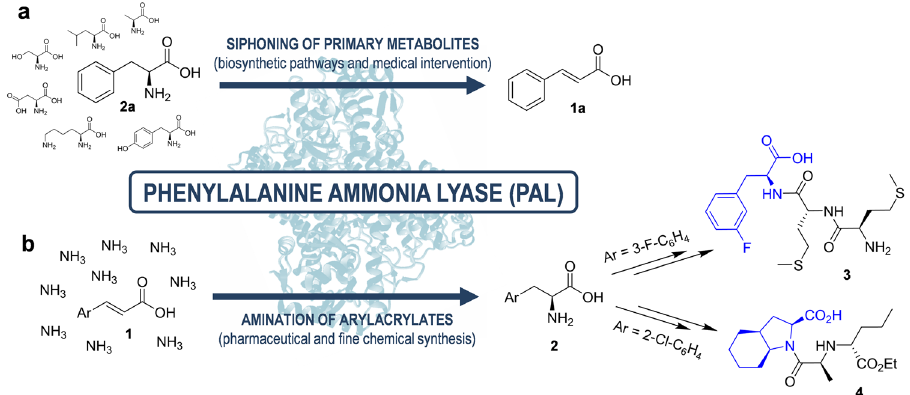
Figure 1. The catalytic activity of phenylalanine ammonia lyase (PAL) enzymes as implicated in biosynthesis/ biotherapeutics ( a ) and biocatalysis ( b